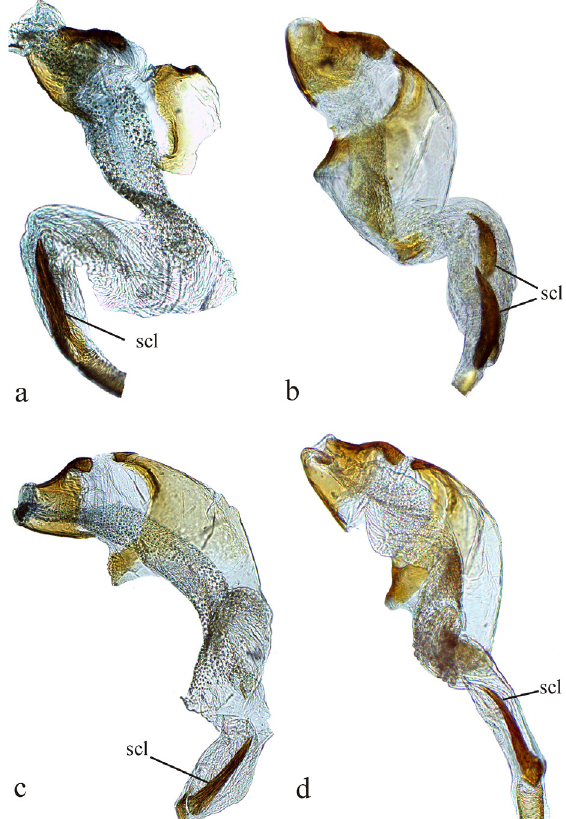
Figure 5. Aedeagus. a, Nabis ( Austronabis ) argentinus . b, N . ( A .) faminei . c, N . ( A .) paranensis . d, N . ( A .) punctipennis . (scl: